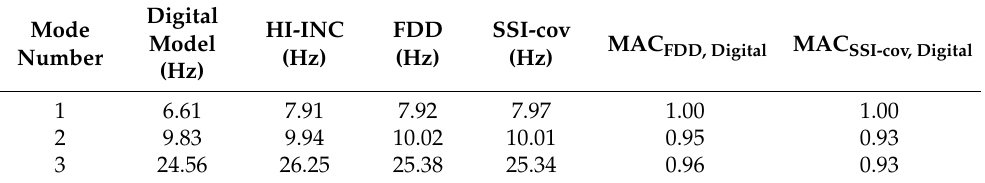
Table 9. Eigenfrequency and MAC value comparison of the experimental analysis with the digi- tal